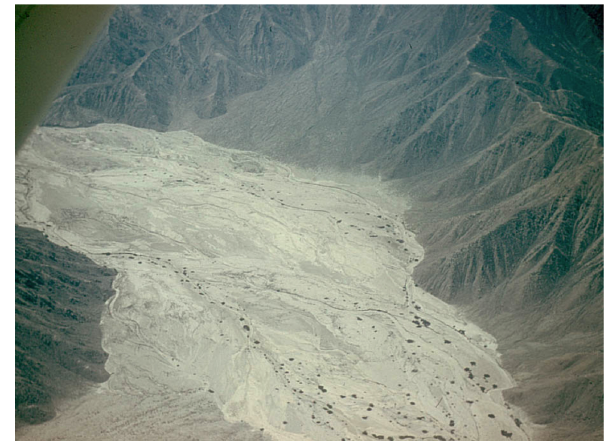
Figure 5. Site survey – March 1960. Aerial view of the site that became the Jicamarca Radio Observatory (picture taken by Ken